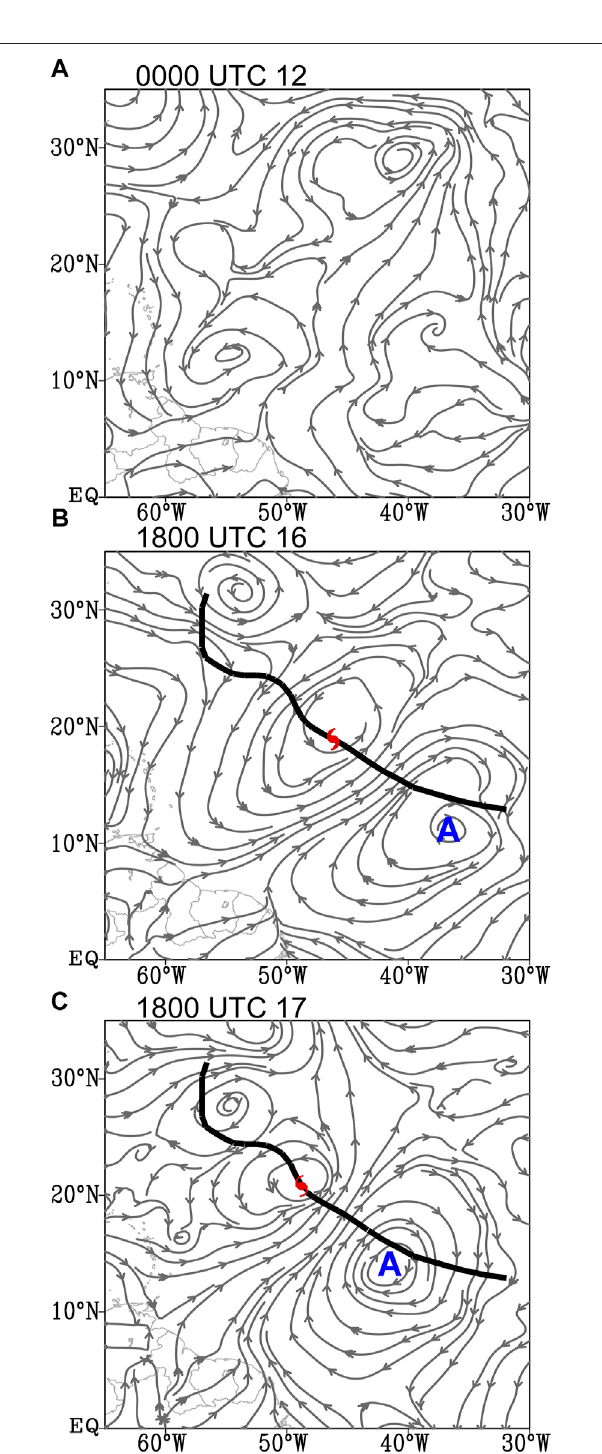
FIGURE 8 | 900-hPa streamline for the synoptic-scale fi eld at (A) 0000 UTC 12 (B) 1800 UTC 16 and (C) 1800 UTC Sep 17, 2006. The thick black solidlineindicatesthetrackofHelenefrom0000UTC14to0000UTCSep22, 2006. The red symbol indicates the TC position at the selected times. The letter “ A ” in blue color represents the anticyclonic